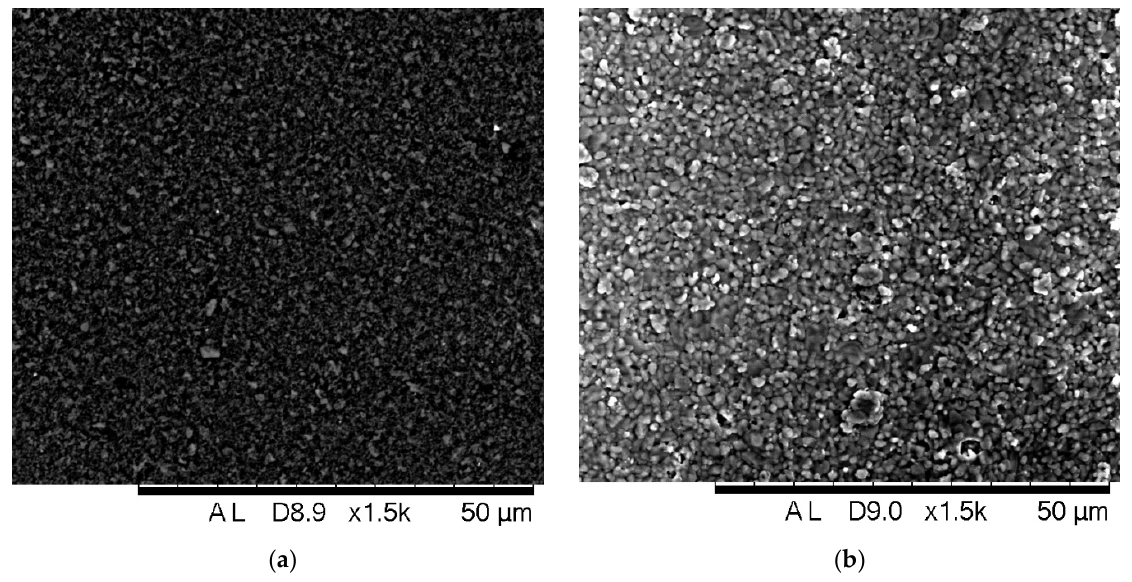
Figure 8. SEM images of the ( a ) green surface and the ( b ) sintered surface.